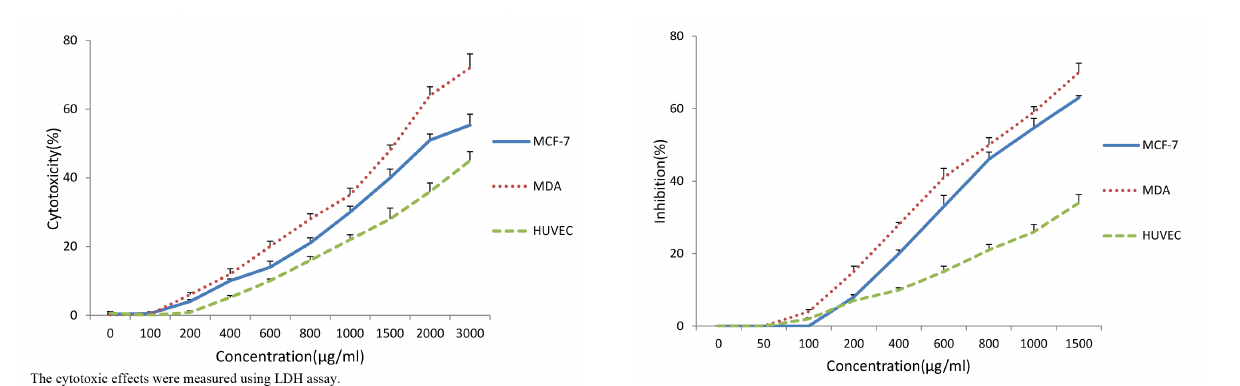
Figure 1. The Cytotoxic Effects of HSPPC on MCF-7, MDA-231, and HUVEC Cells.